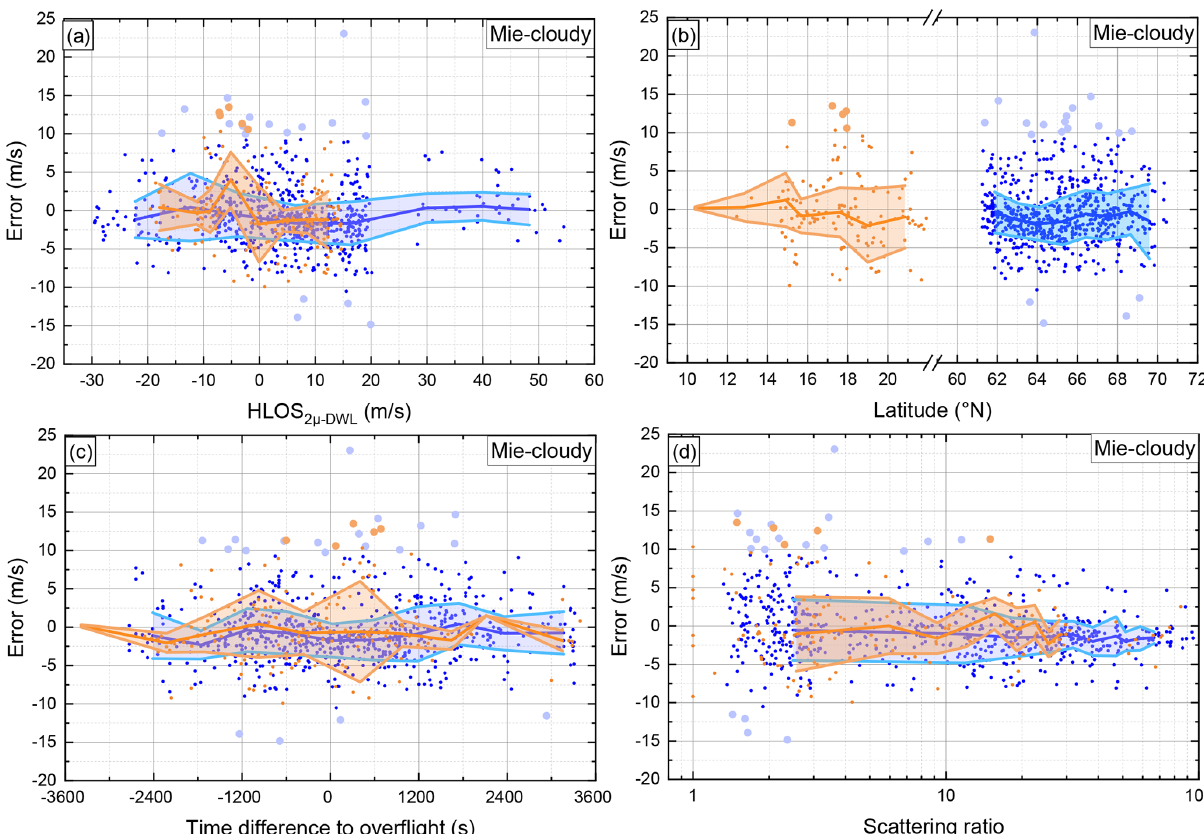
Figure 9. Aeolus Mie-cloudy HLOS wind speed error with respect to 2µmDWL measurements depending on 2µmDWL-measured wind speed (a) , on latitude (b) , on the time difference between Aeolus and 2µmDWL observation (c) , and on the scattering ratio (d) . The data set of the AVATAR-I campaign is indicated in blue, and the one of AVATAR-T in orange. The solid lines denote the median value for certain intervals; the shaded areas represent the median ± scaled MAD. Large dots represent outliers which were identified by modified Z score with a threshold of 3 that is calculated for the respective averaging